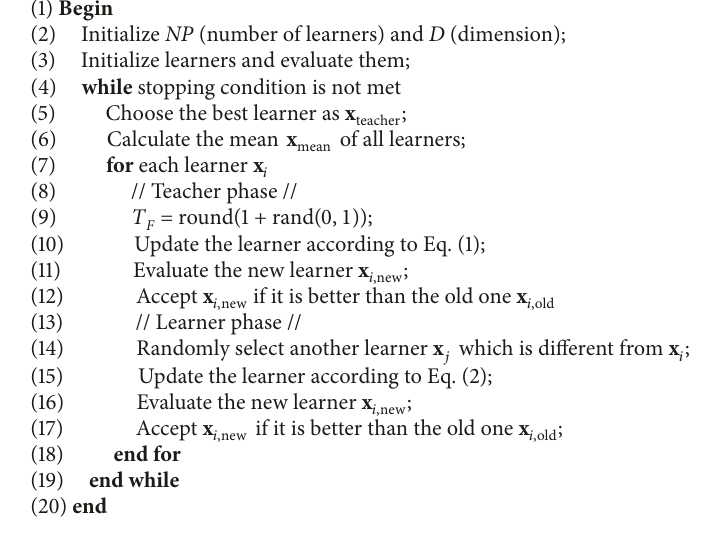
Algorithm 1: Basic